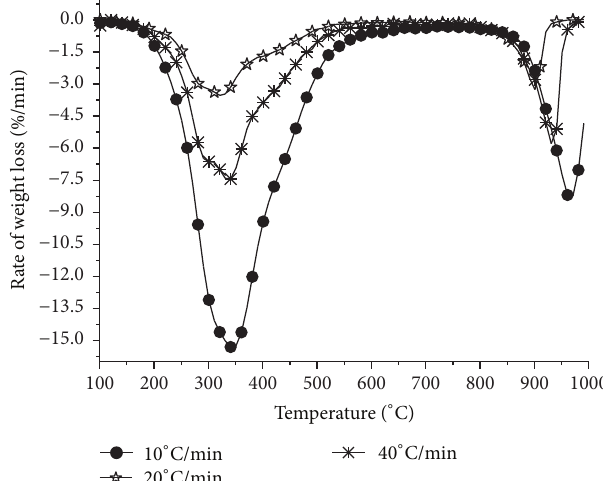
Figure 4: DTG curves of Chlorella vulgaris decomposition at the heating rates of 10, 20, and 40 ∘ Cmin −1 in CO 2